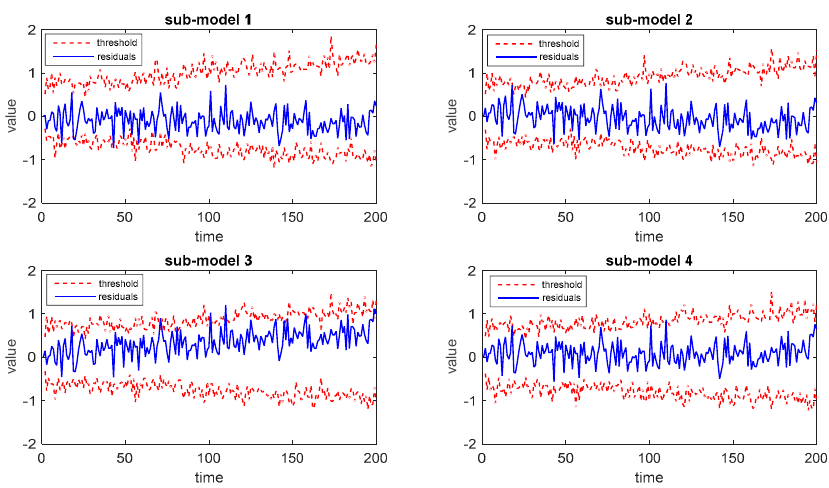
Processes 2020 , 8 , 164 Figure 3. The solution of optimal trajectory in numerical example. Figure 3. The solution of optimal trajectory in numerical example.